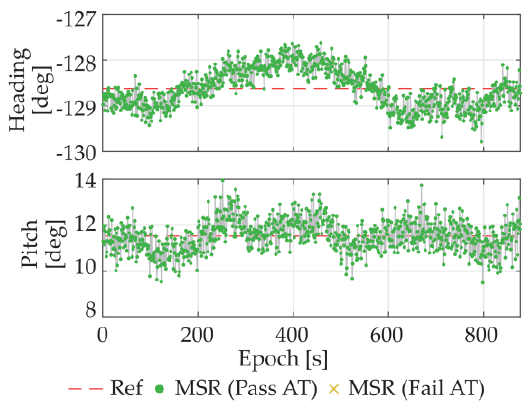
Figure 9. Attitude results of the static experiment under open area.